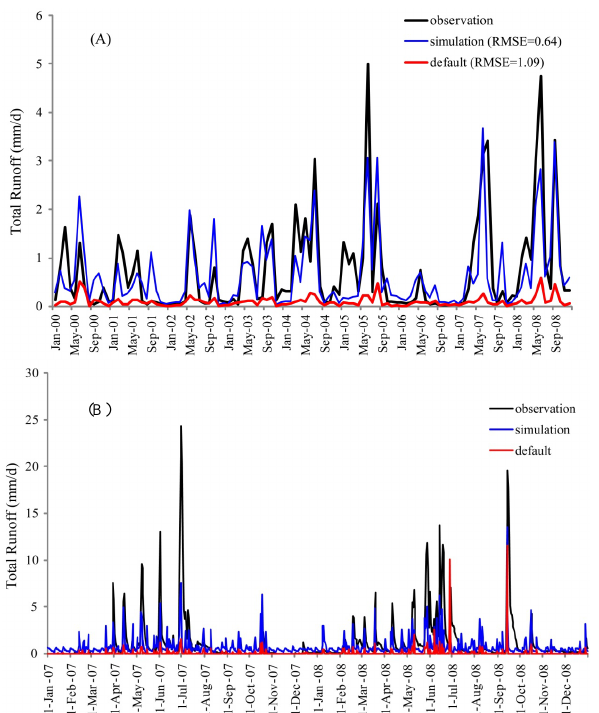
Figure 15. Comparison among the observations, default and optimal simulations of (A) monthly 839 Fig. 15. Comparison among the observations, default and optimal and (B) daily runoff, during the inversion (2002-2005) and validation (2000-2001 and 2006-840 2008) periods at the MOPEX basin. Only the last two years of the daily data are plotted for better 841 simulations of (A) monthly and (B) daily runoff, during the inver- illustration. The RMSEs are calculated for the validation periods. 842 sion (2002–2005) and validation (2000–2001 and 2006–2008) peri- ods at the MOPEX basin. The RMSEs are calculated for the valida- tion